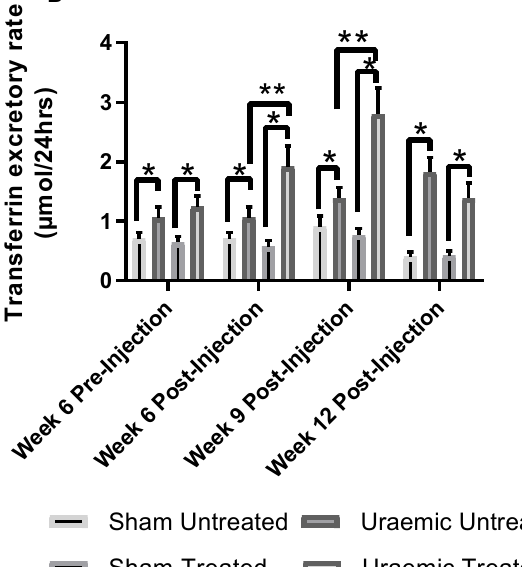
Figure 4. Cont . Antioxidants 2019 , 8 , x FOR PEER REVIEW